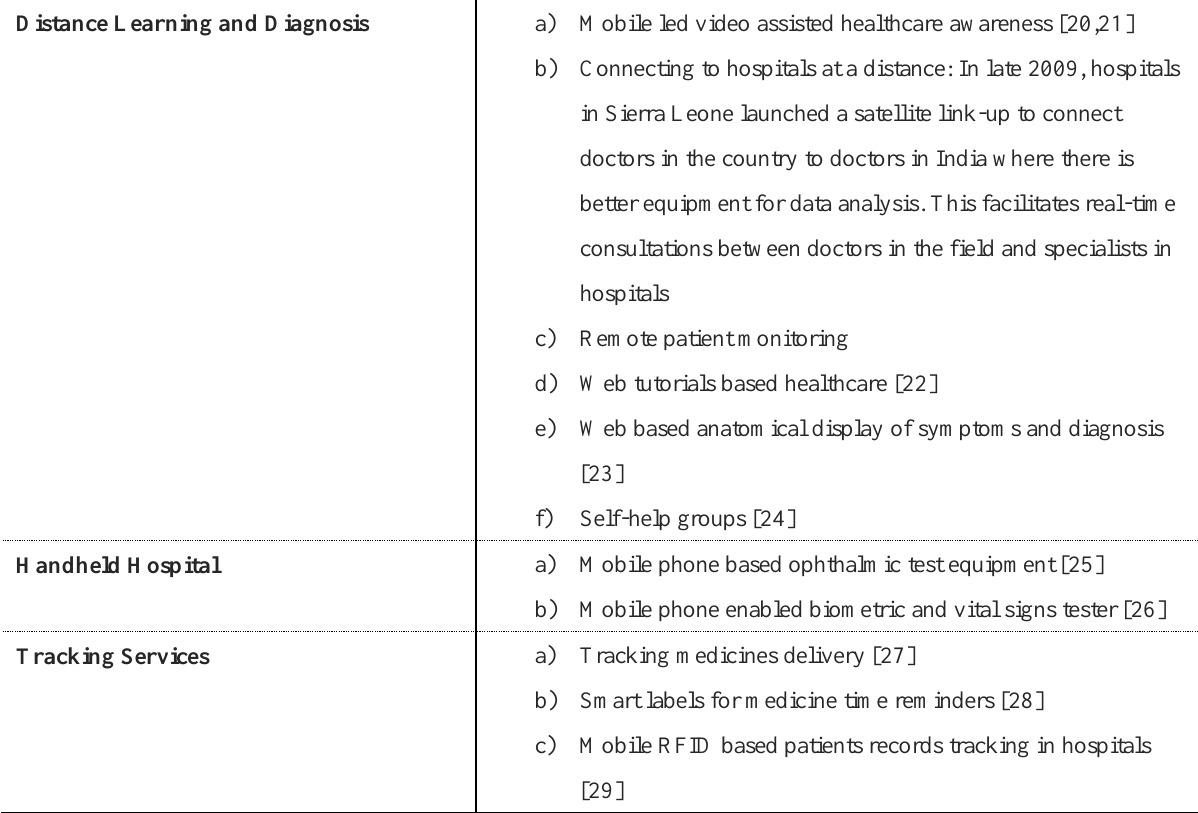
Table 3: The potential use of EVDO and HSPA technology in facilitating healthcare